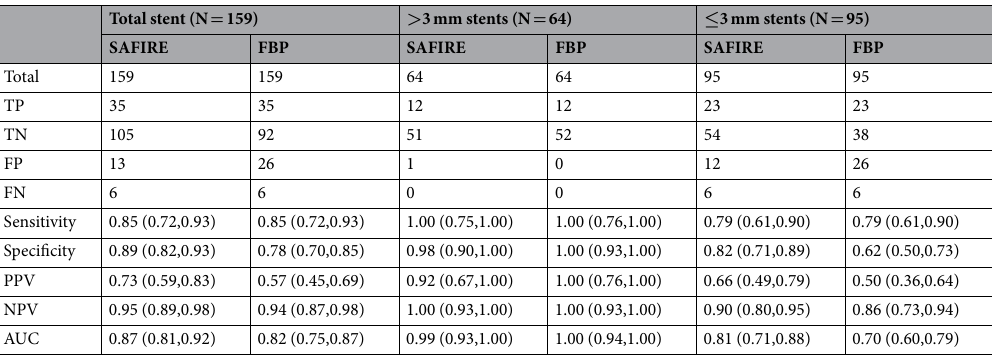
Table 5. Diagnostic performance of iterative reconstruction in detecting in-stent patency. Values are n or n/N[95% CI]. FBP = Filtered back projection. SAFIRE = sinogram affirmed iterative reconstruction. TP = True Positive. TN = True Negative. FP = False Positive. FN = False Negative. NPV = Negative Predictive Value; PPV = Positive Predictive Value; AUC = Area Under